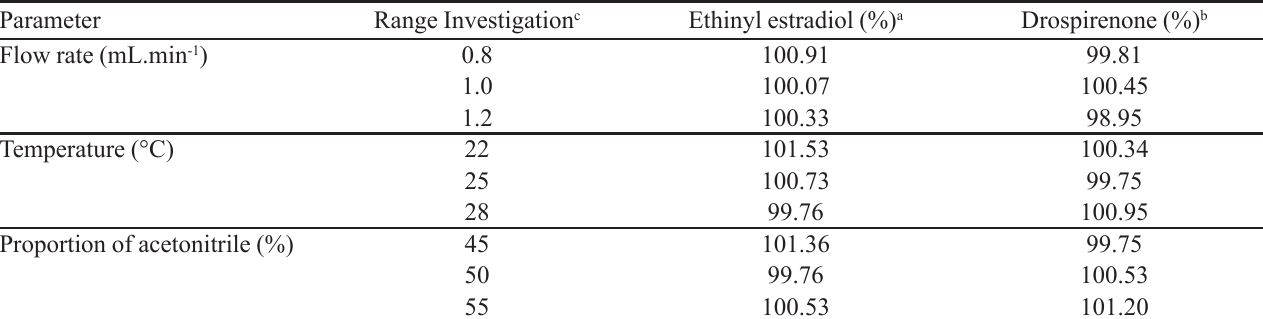
TABLE V - Chromatographic conditions and range investigated during robustness testing